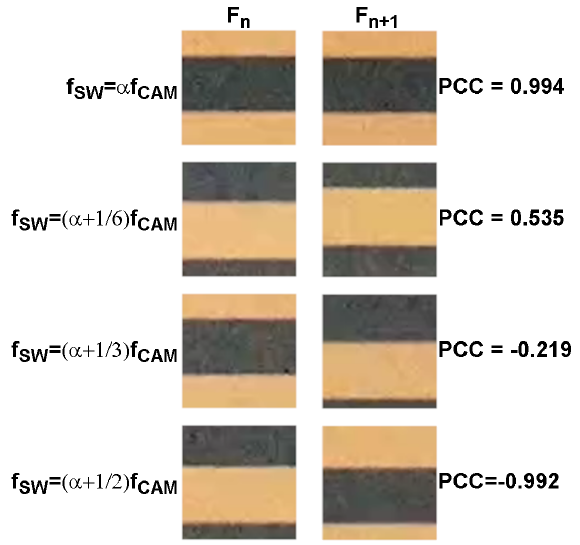
Figure 13. Example of obtained ROIs for α = 15 at D = 15 m with the calculated